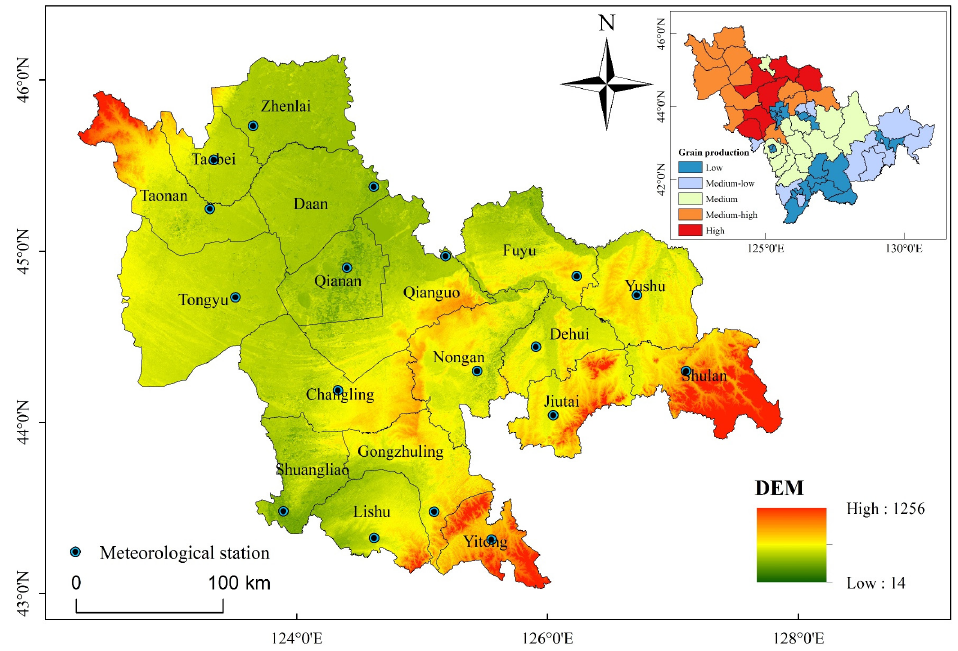
Figure 1. Research area map. Table 1. Overview of the situation in each region.